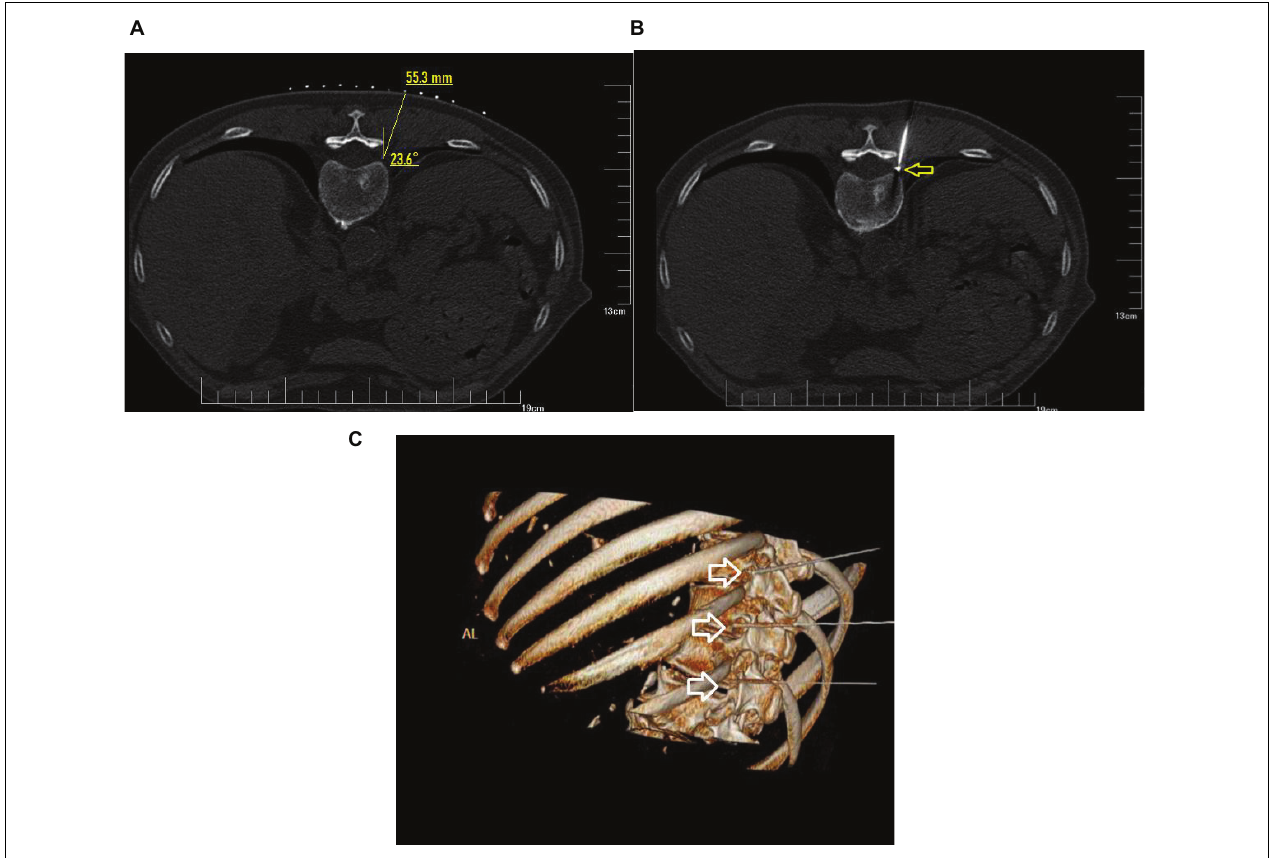
FIGURE 2 | CT guidance: CT plain scan and 3D reconstruction. (A) Under CT guidance, a safe route was chosen to avoid injury to the vessel, pleura, and lung. The puncture point and puncture angle were clearly defined by computer. (B) CT scan showed that the radio frequency needle was located at the spinal nerve root on the left side and adjacent to the pleura and lung as shown by arrow. (C) The puncture needles of the three segments of the thoracic vertebrae were located at the intervertebral foramen as shown by the arrow.